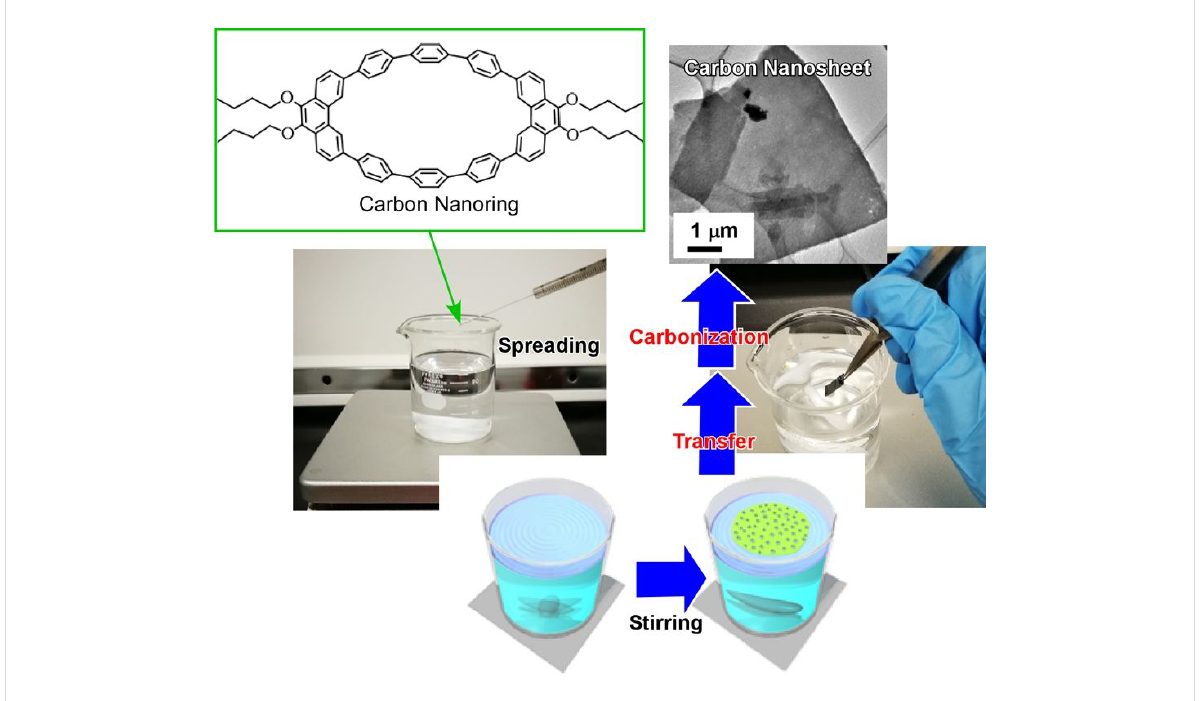
Figure 14: Fabrication of two-dimensional nanocarbon films from a carbon nanoring molecule (9,9 ′ ,10,10 ′ -tetrabutoxycyclo[6]paraphenylene[2]-3,6- phenanthrene) via a newly developed vortex LB method at a liquid interface with dynamic flow followed by heat treatment under inert gas atmosphere. Both photographs were reproduced with permission from [68], copyright 2019 The Royal Society of Chemistry; the TEM image was reproduced from [75], copyright The authors.